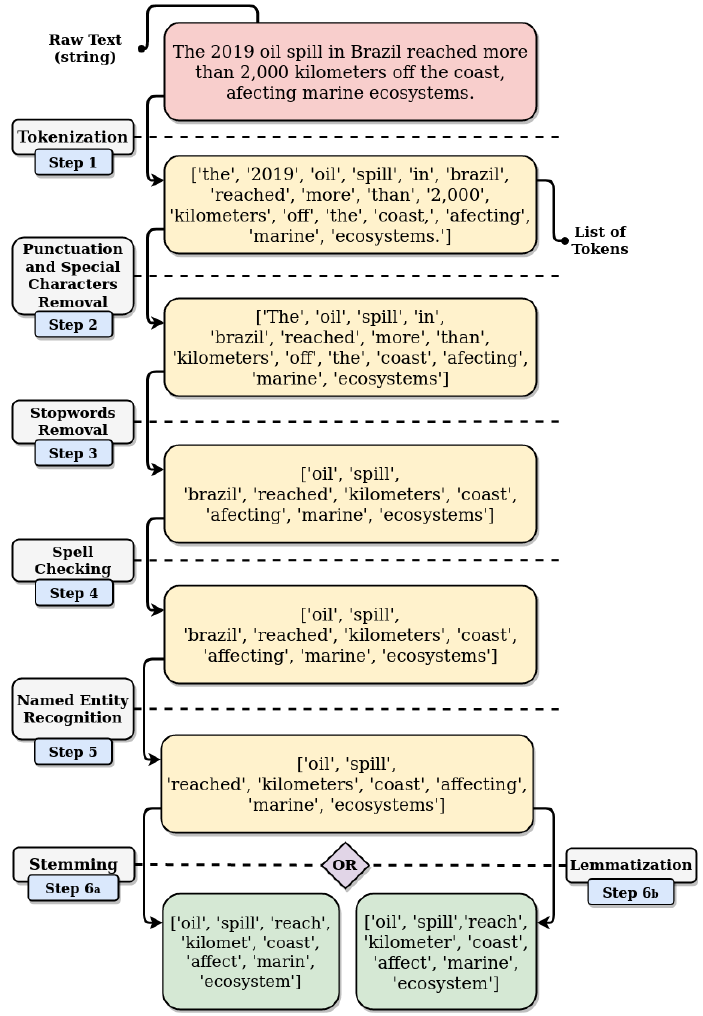
Figure 2. Application of natural language processing in raw text. The tokenization segments contiguous text into a set of tokens. Elements of small semantic relevance are removed, as well as punctuation, special characters, and stopwords. Named entities are identified and removed. Stemization or lemmatization reduces the diversity of